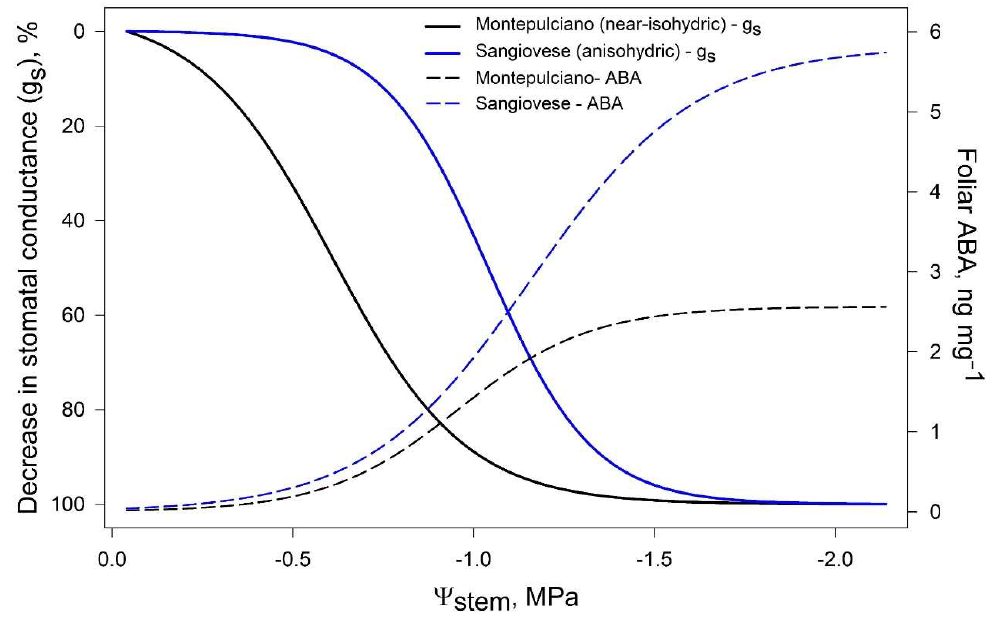
Figure 4. Modelled dynamic of stomatal conductance (g s ) and foliar ABA concentration in a near-isohydric cv (Montepulciano) and an anisohydric cv (Sangiovese). Elaboration on data by [19].